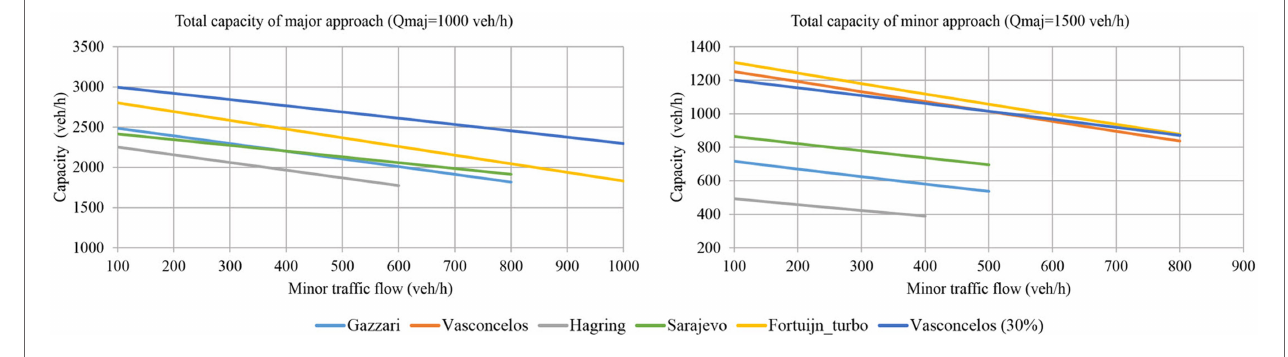
FIGURE 8 | Capacity and v / c curves for scenario A 8